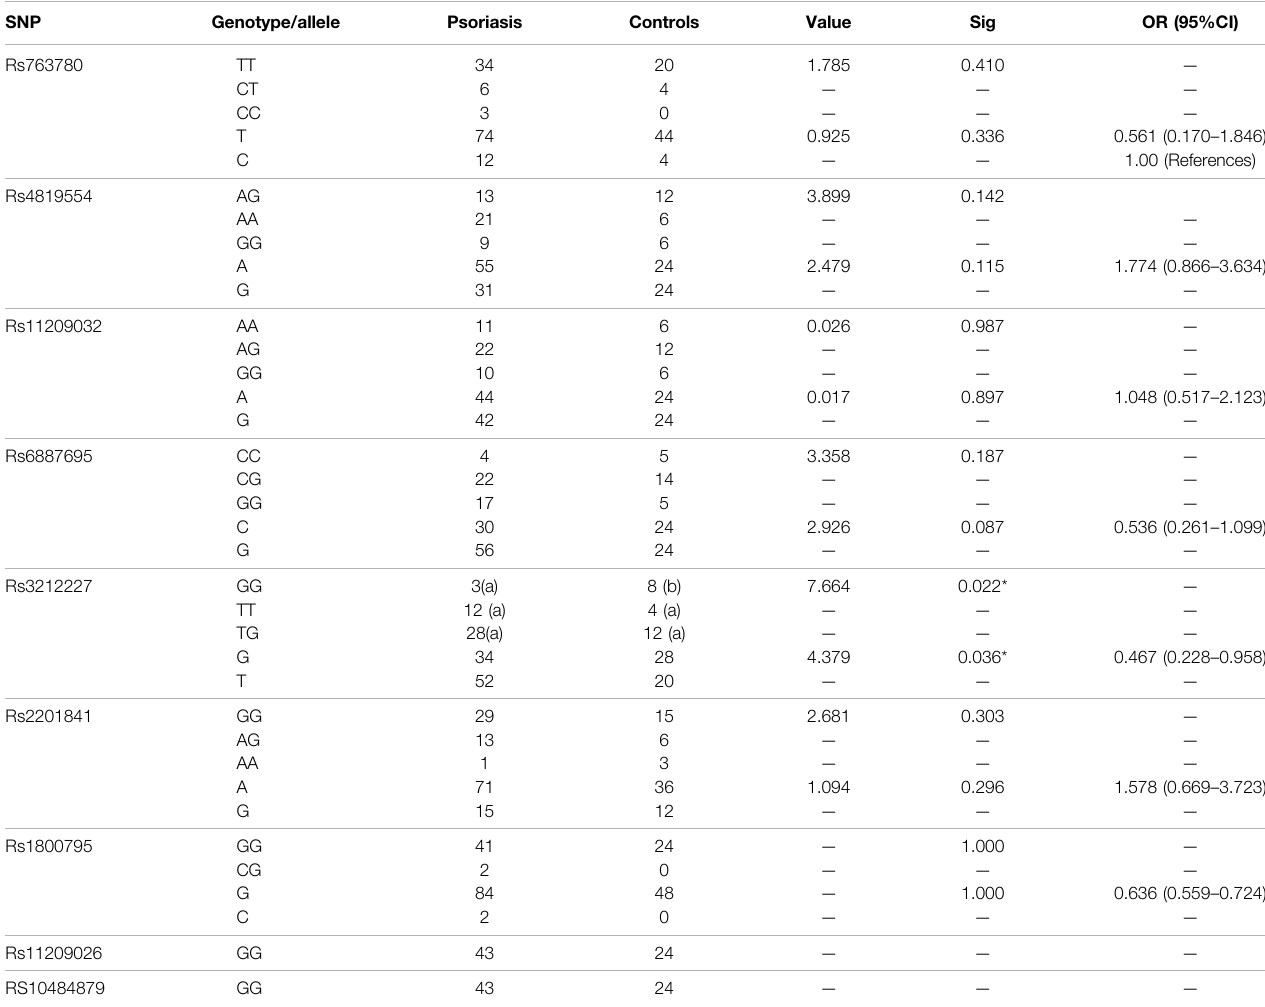
TABLE 2 | Association of the alleles at SNPs and the genotype frequency with susceptibility to psoriasis. SNP